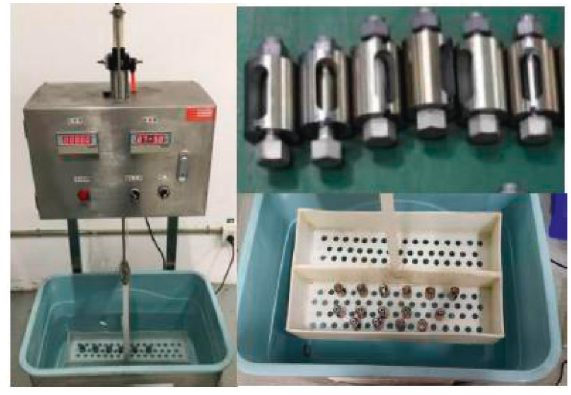
Figure 4: Test chamber. Table 1: Installation requirements.